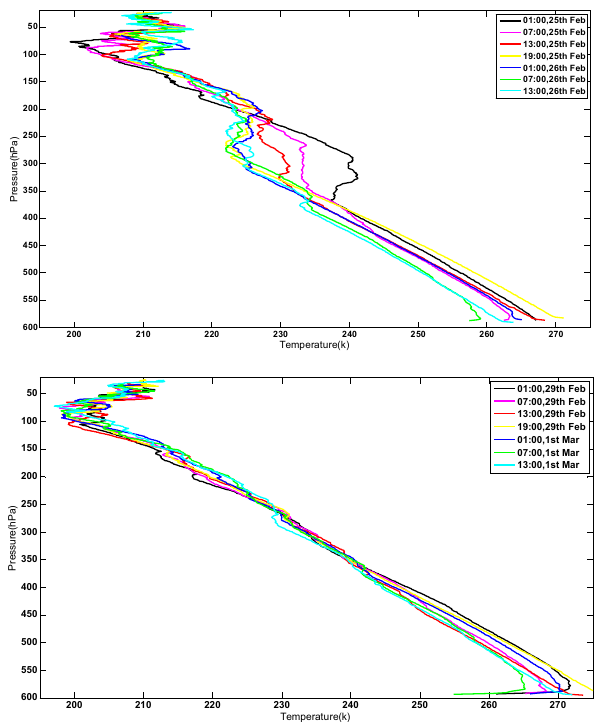
Fig. 2. (a) Temperature profiles from 25 February 2008, 01:00 to 26 February 2008, 13:00LT at Gerze site. (b) Temperature profiles from 29 February 2008, 01:00 to 1 March 2008, 13:00LT at Gerze site.